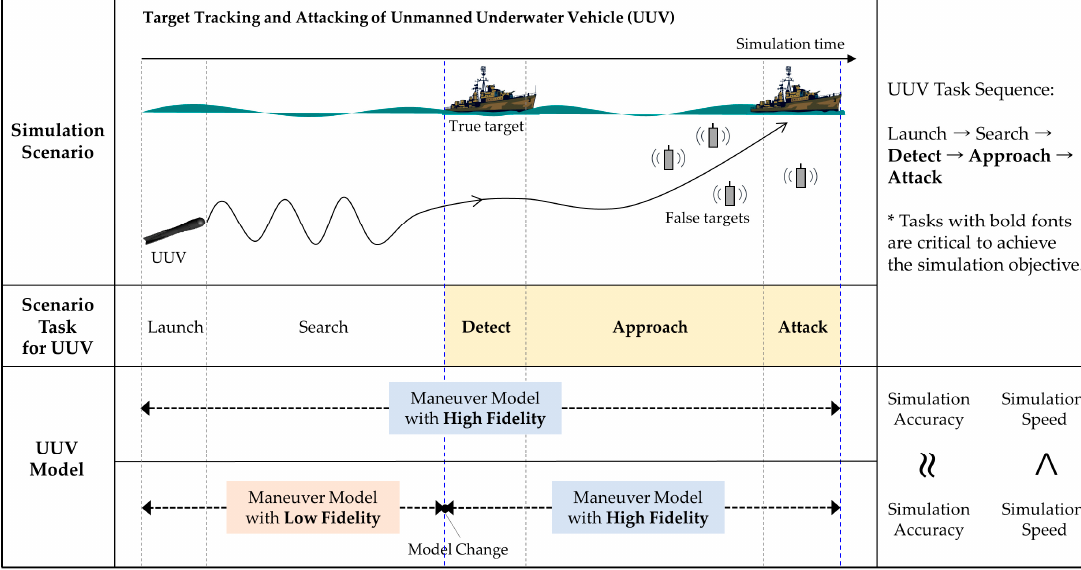
Figure 4. Interest region in a single simulation scenario: Target attacking scenario of an unmanned underwater vehicle (UUV).